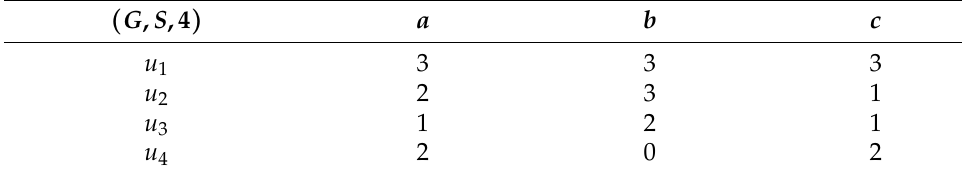
Table 6. The 4-Soft Set of ( F , S ,4 )